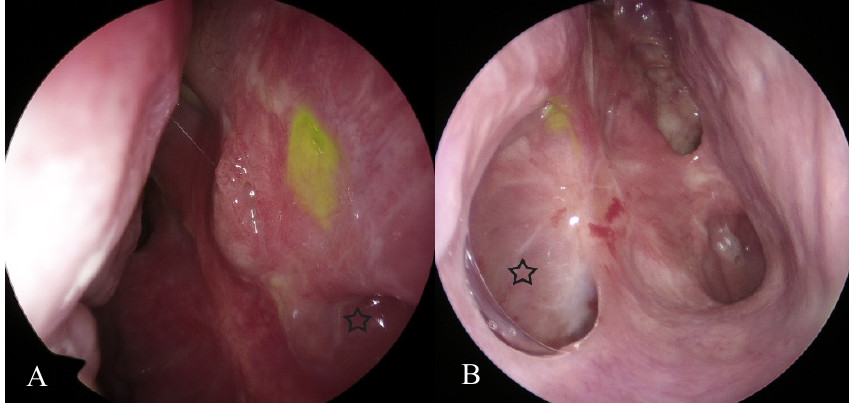
Figure 2. Modified endoscopic Jones I test. Profuse leak of floresceine dye could be observed almost immediately (within first minute) after application in most of our patients ( A ) and weak leak observed after more than 3 min after dye application in patients with tear drainage disorders ( B ), asterix—maxillary sinus.